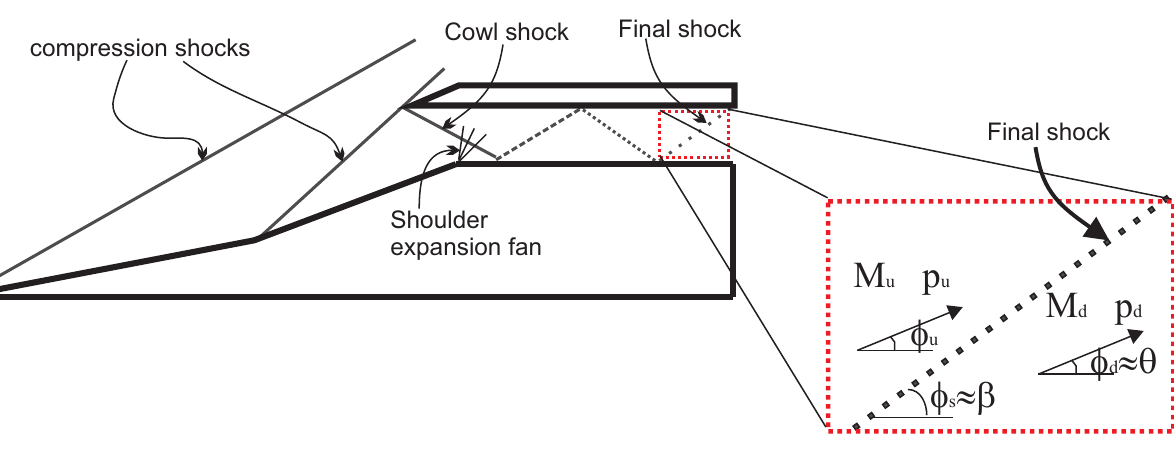
Figure 19. Schematic of the typical internal shock structure resulting from interactions between the cowl shock and expansion